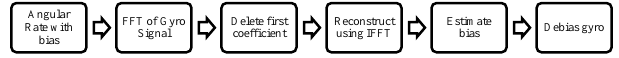
Figure 4 FFT based automatic gyroscope de-biasing